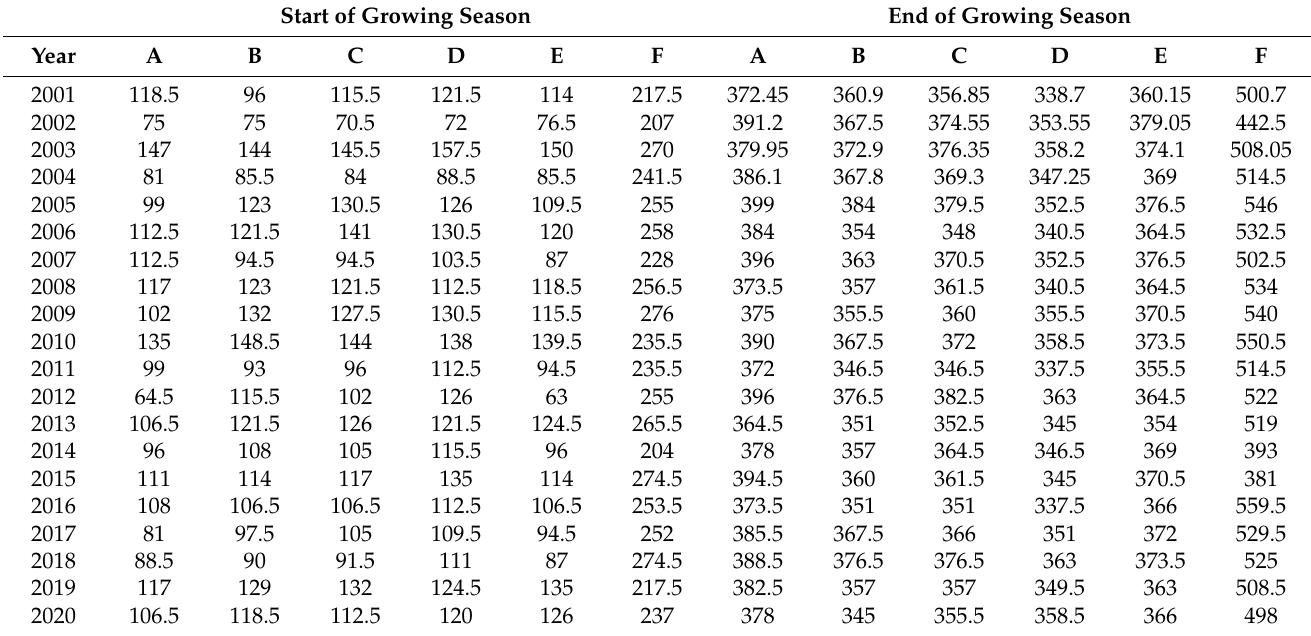
Table 1. Start and End of growing Season of grassland in Biobio from 2001 to 2020 by agro-climatic